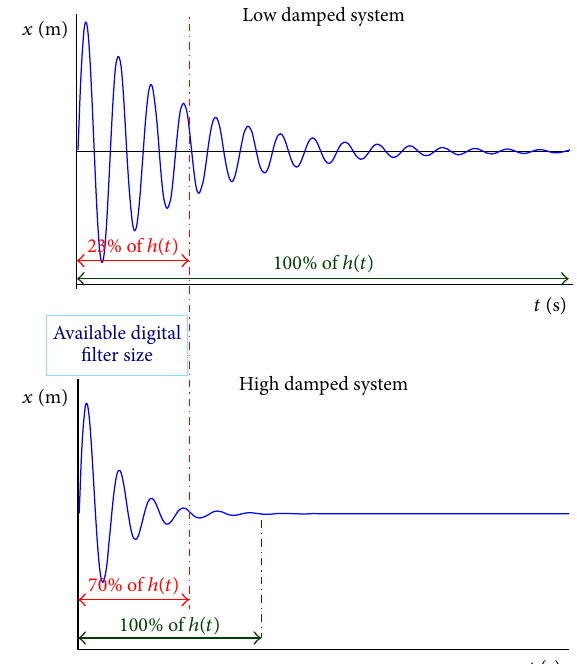
Figure 9: Portion of system impulsive response acquired with a given digital filter size.